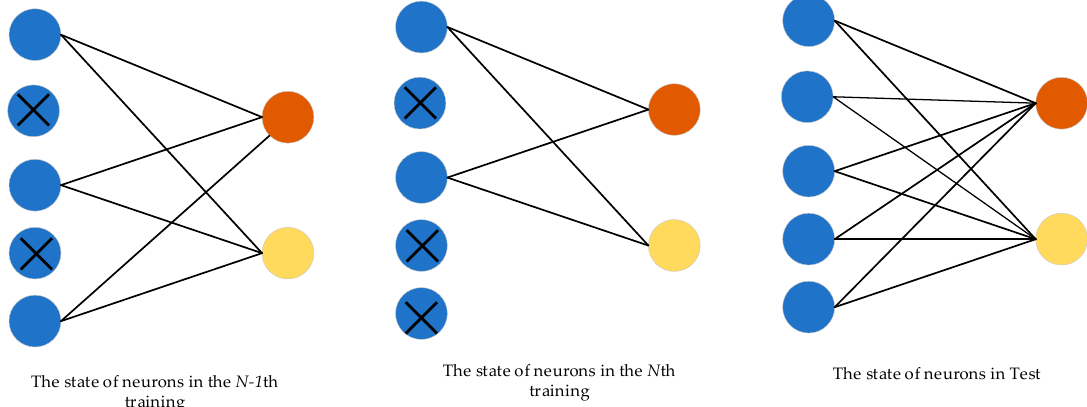
Figure 3. Working principle of dropout. “×” means that the neuron is dropped out.